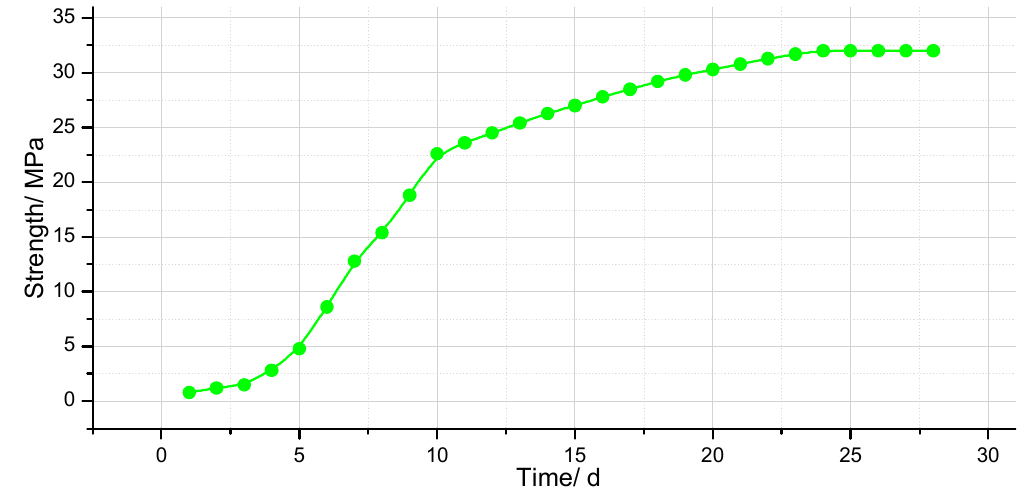
Figure 12. The strength change of filling body.